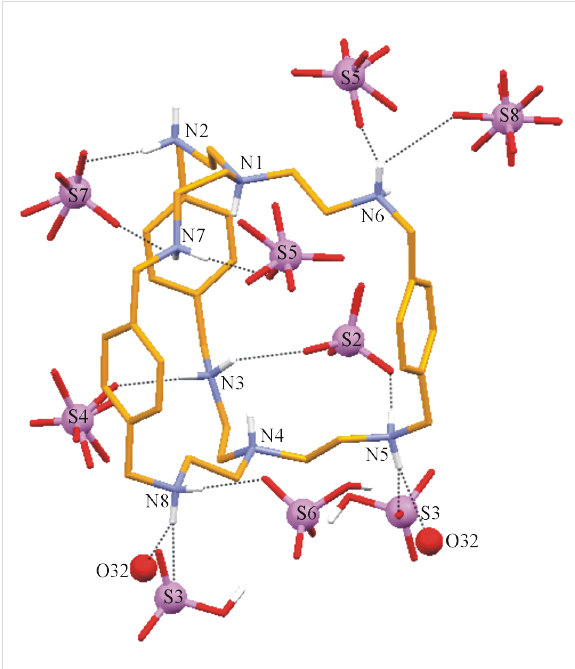
Figure 6: Interactions of the protonated amino nitrogen centers of the [H 8 L 1 ] 8+ moiety with the surrounding hydrogen sulfate and water molecules.